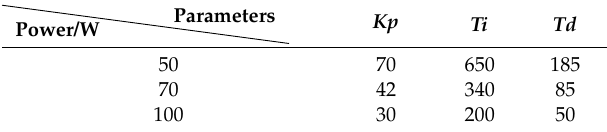
Table 1. The PID detail parameters for different irradiation power